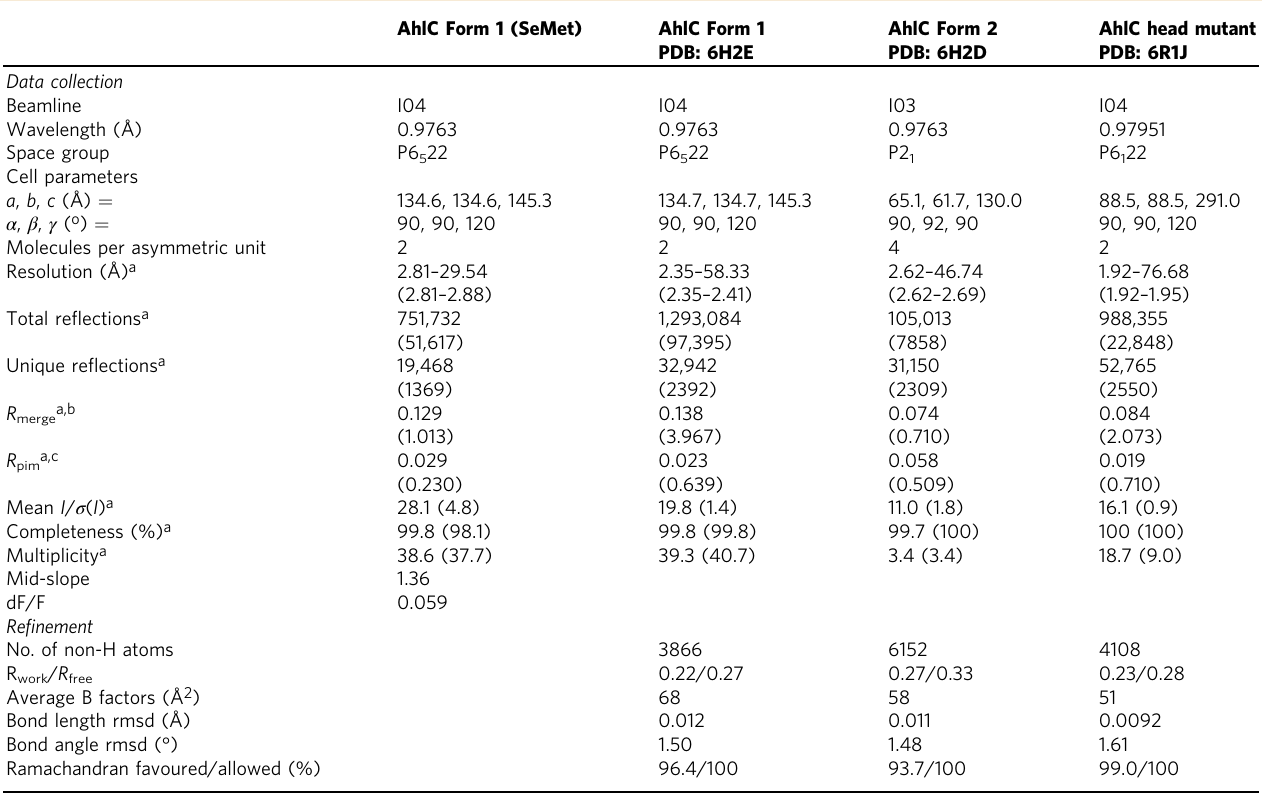
Table 2 X-ray data collection and re fi nement statistics for AhlC